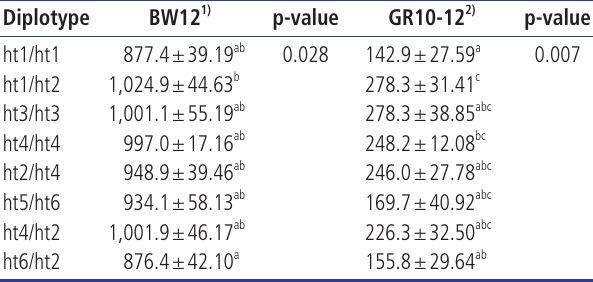
Table 3. Effects of diplotype of the THRSP gene on BW12 and GR10-12 (LS means±SE)